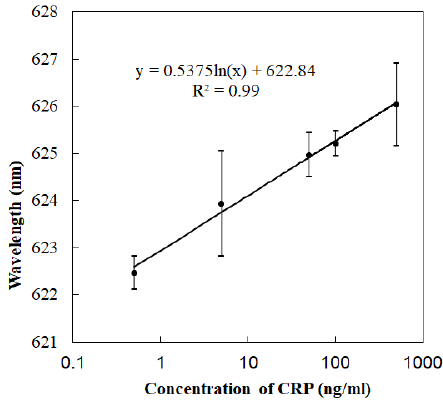
Figure 5. The SPR immunosensor results for the CRP standard buffer samples (0.5–500 ng/mL) assayed using Au nano-particle labels. Error bar with 3 tests.